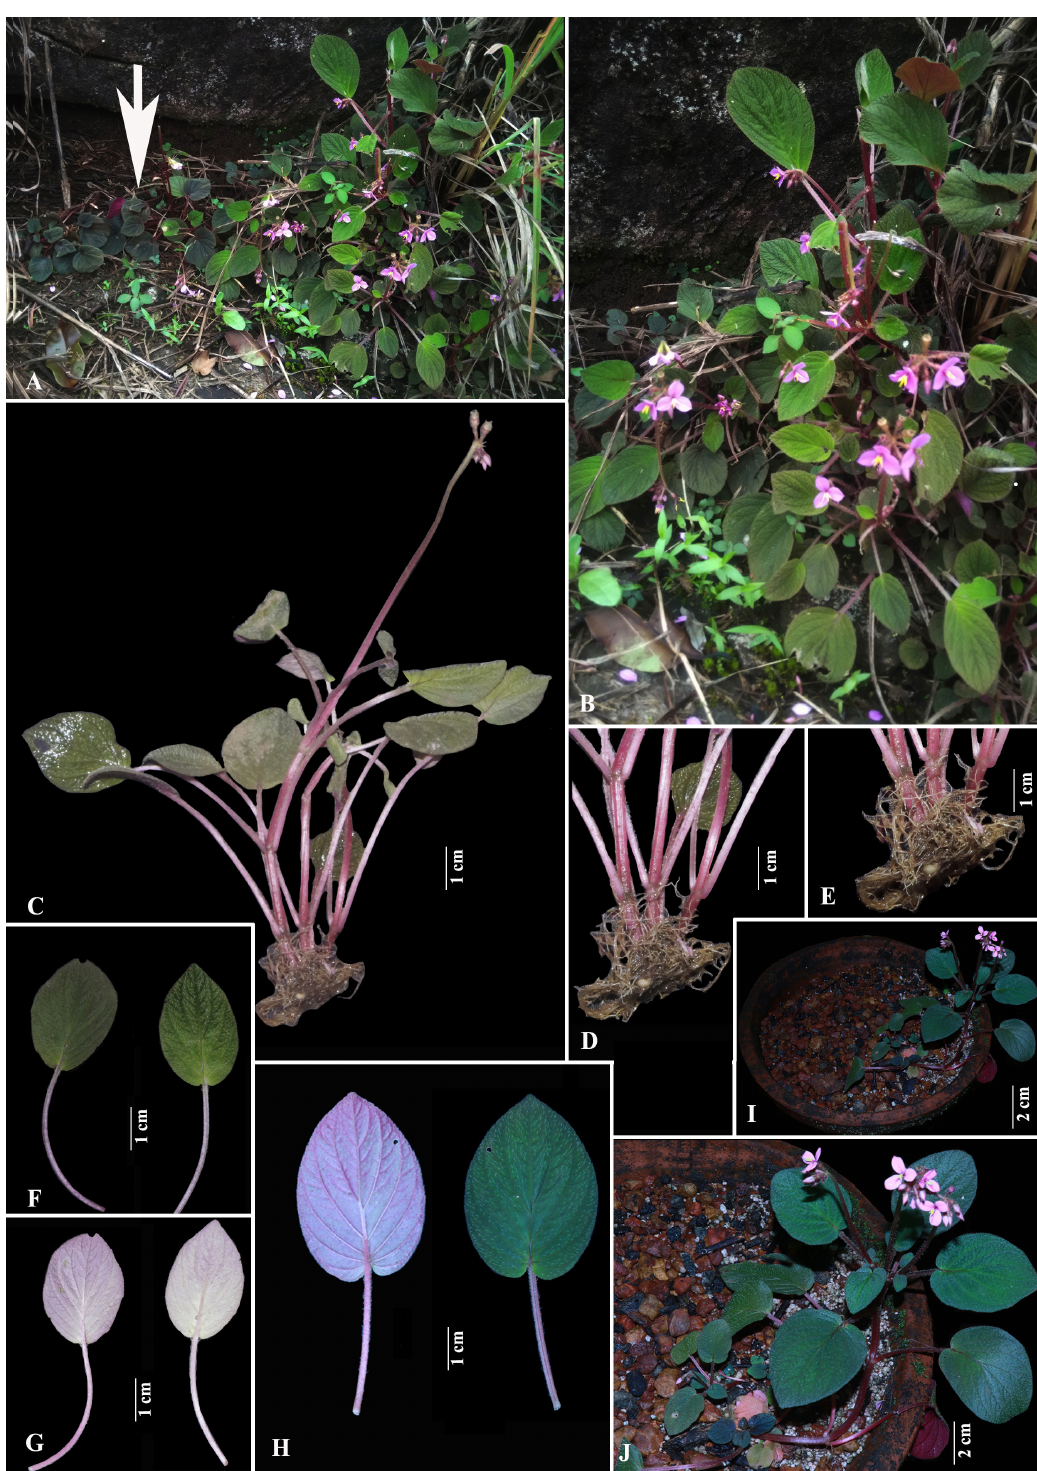
Fig. 2. Sonerila longipedunculata Resmi & Nampy sp. nov. A – B . Plants in natural habitat, see also S. raghaviana Ratheesh et al. nearby (white arrow) . C . Habit. D – E . Base of stem showing tuberous root stock. F – G . Leaves, adaxial and abaxial views. H . Leaves, abaxial and adaxial views showing venation. I – J . Plants under cultivation. Photographs by Resmi S. based on Resmi S. & Santhosh Nampy 151222